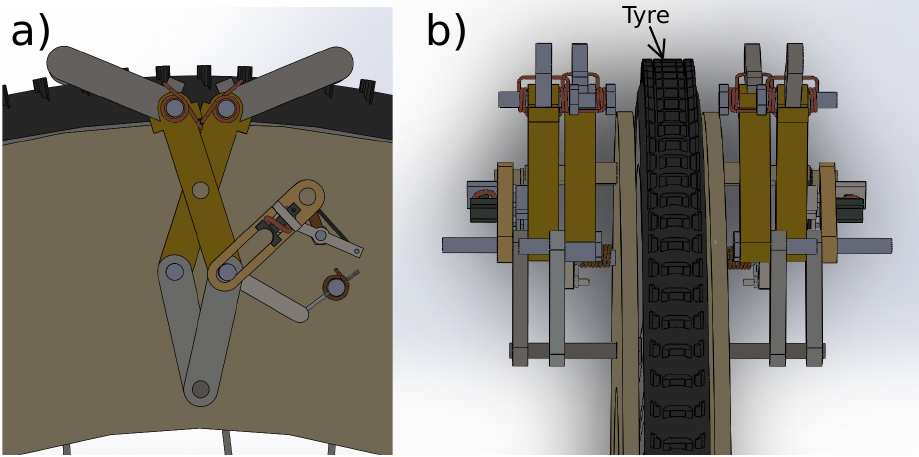
Figure 12. 3D model of anti-slip wheel mechanism ( a ) front view; ( b ) side view.